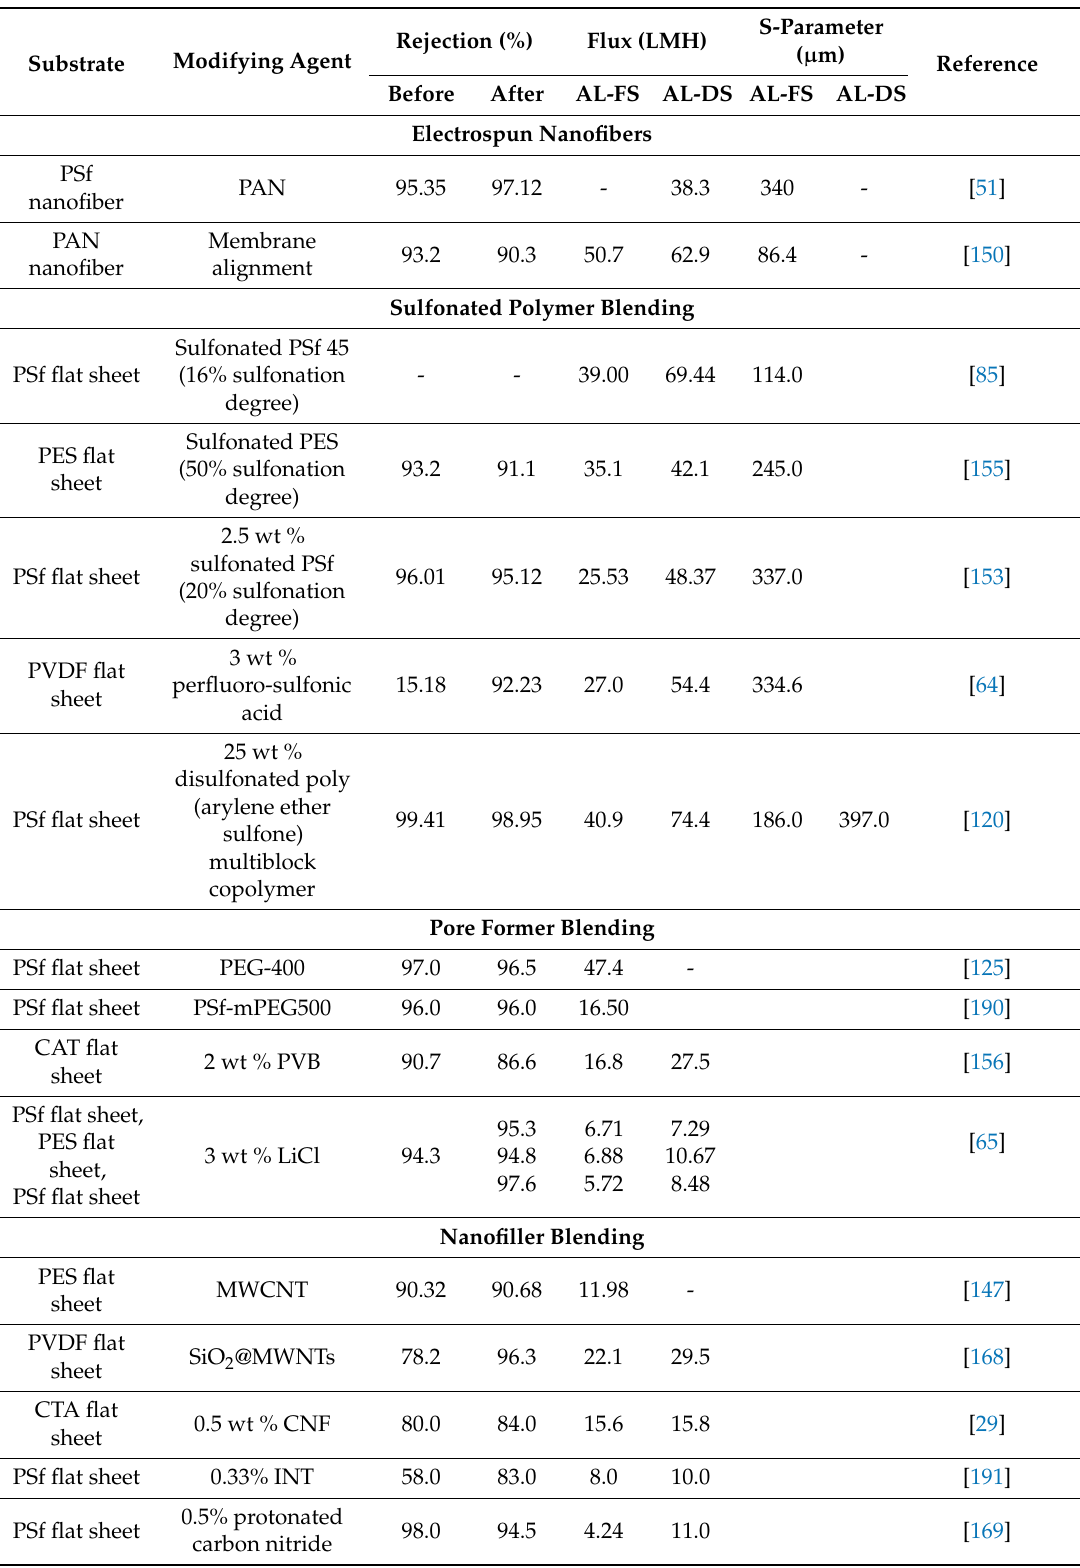
Table 1. Overview of the e ffi ciency of di ff erent substrate modifications for FO desalination application.